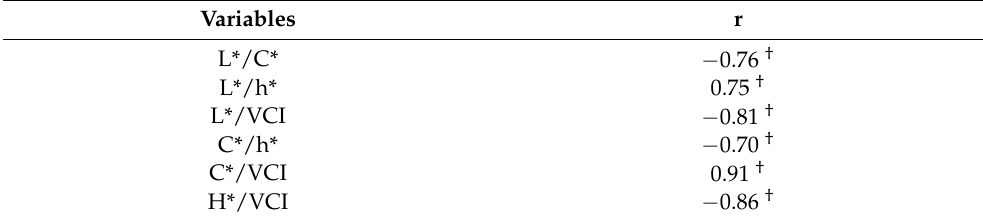
Table 2. Pearson correlations (r) between different variables related to flower colour of five accessions of A. pallida